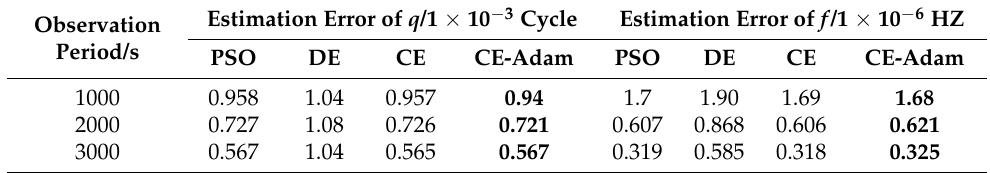
Figure 6. Estimation error of f for CE, DE, PSO and CE-Adam algorithm. Table 2. Estimation error of q and f